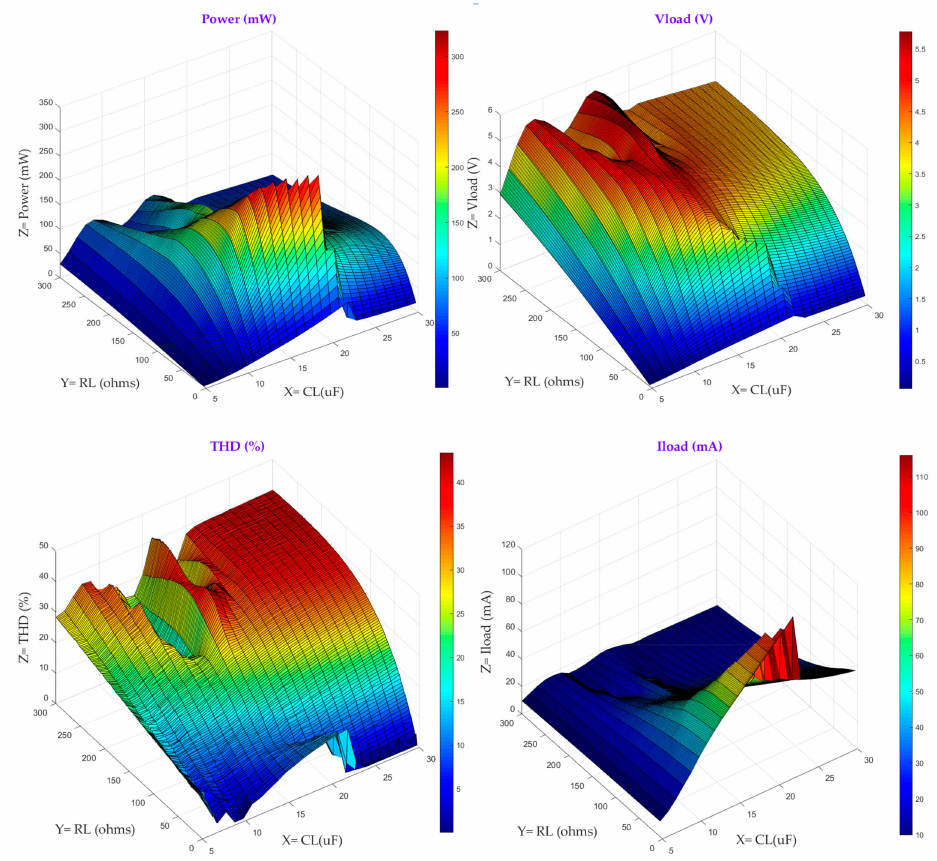
Figure 6. Power, THD, V load and I load as a function of R L and CL for Ip = 5 A and Ns =